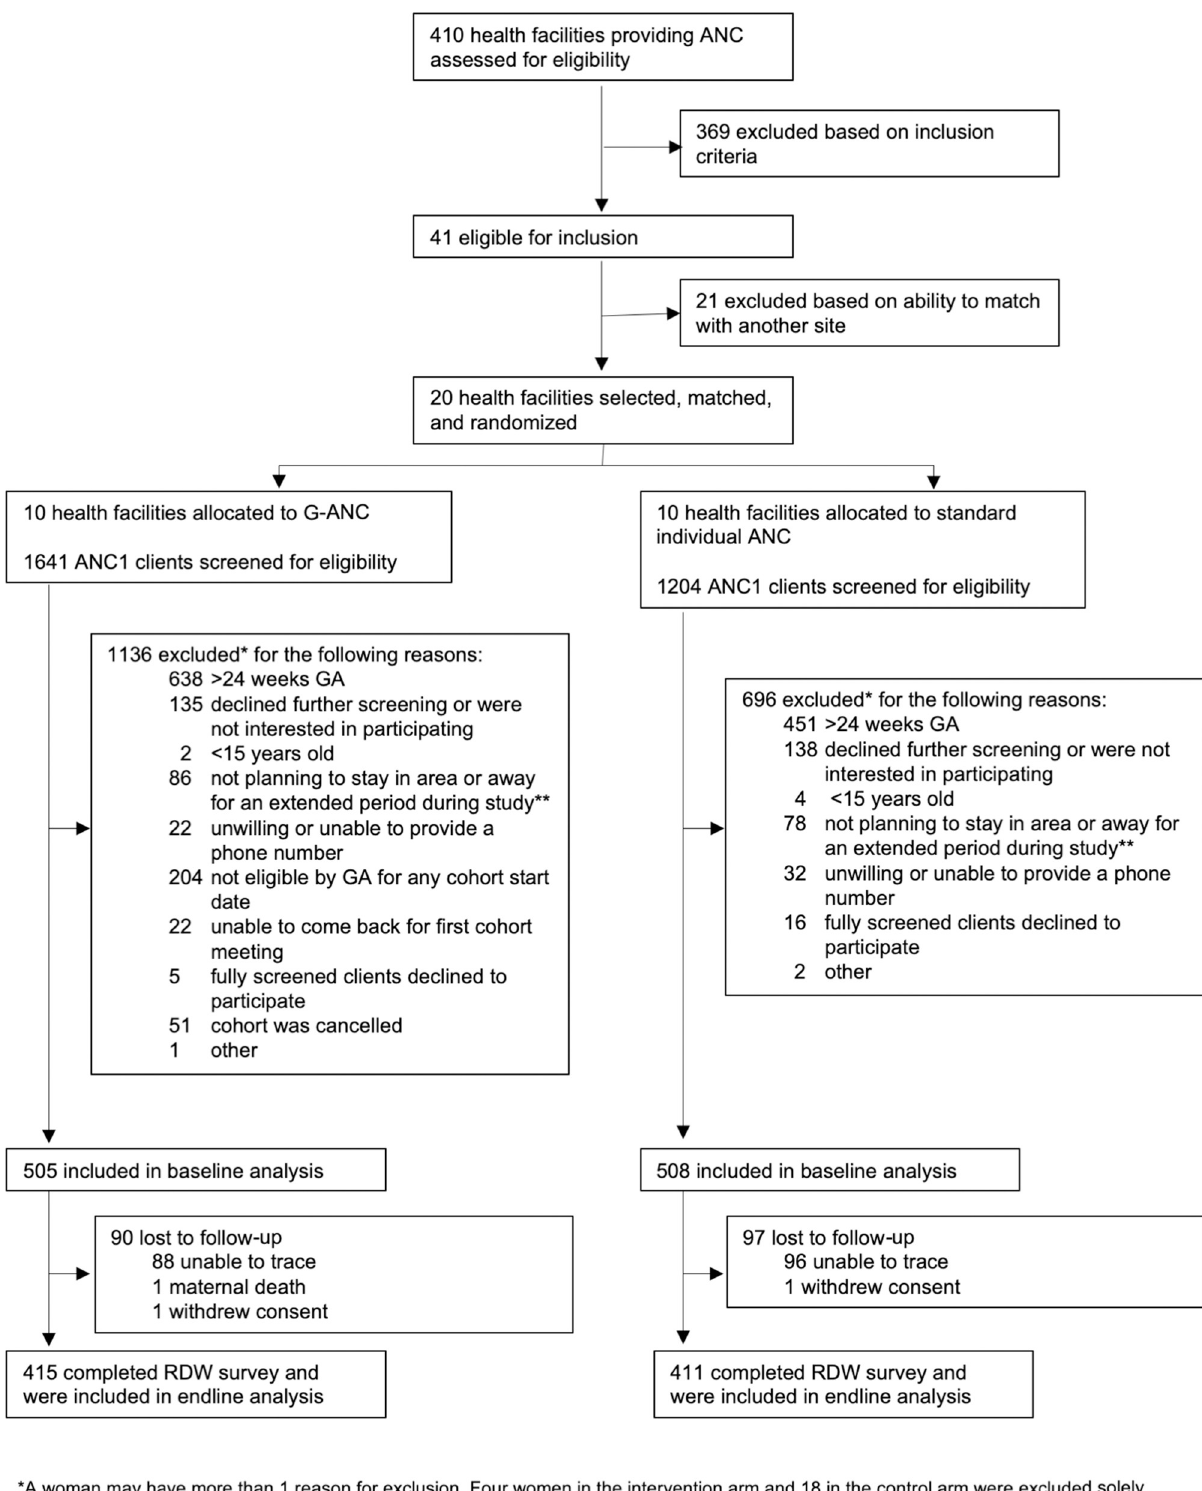
Group antenatal care impact on quality of care, ANC attendance and facility-based delivery